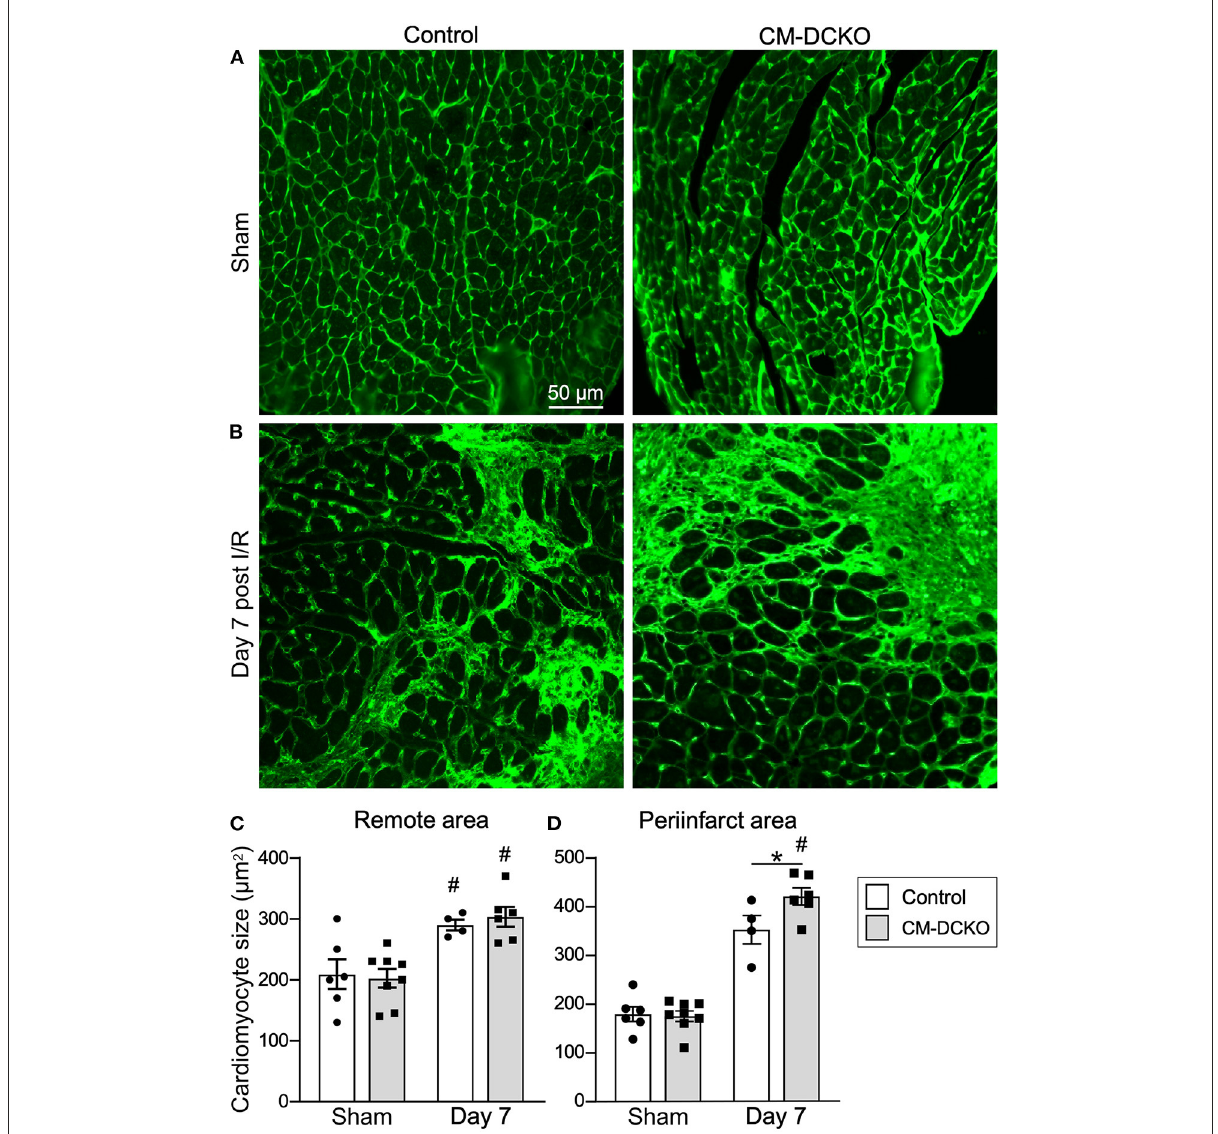
FIGURE3 The cardiac hypertrophic response after cardiac I/R injury is minimaly affected by lack of cardiomyocyte Fgfr1 and Fgfr2 . (A,B) Representative images of WGA (green) stained cardiomyoctyes in the LV free wall of Control and CM-DCKO hearts at 7 days after sham operated (A) or I/R injury (B) . (C,D) Quantitation of myocyte cross sectional area in the septum [ (C) , Remote area and (D) , periinfarct area] showing no significant difference in the cardiac hypertrophic response between Control and CM-DCKO mice in the remote area and a small increase in myocyte area in the periinfarct region in CM-DCKO mice. Scale bar = 50 µ m; n = 4–8; # P < 0.05 vs. sham (of the same genotype); * p < 0.05 vs. Control.